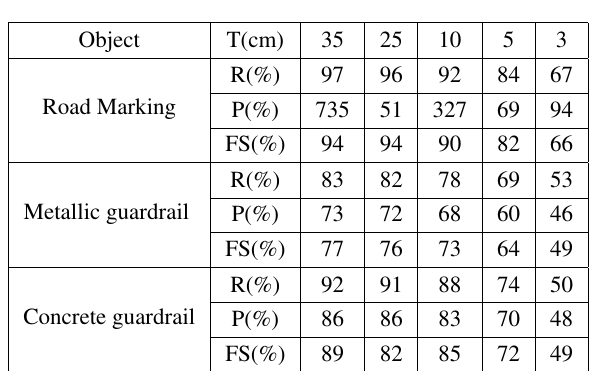
Figure 7. Different vectorization of the detected markings road.